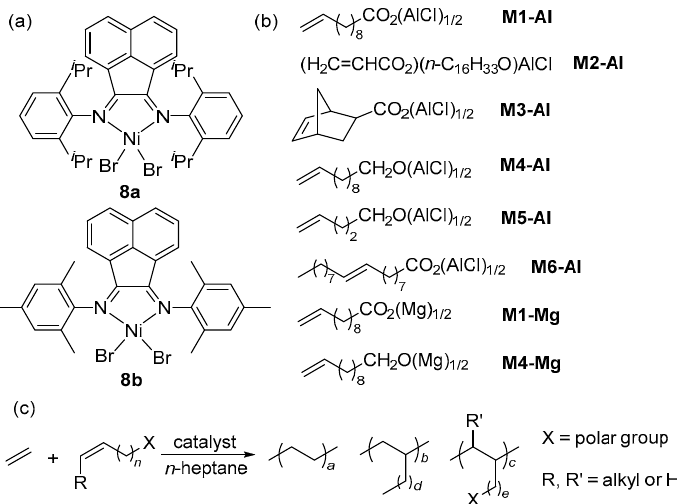
Figure 6. ( a ) Nickel catalysts 8a , b for olefin copolymerization; ( b ) different metal–salt-based polar monomers; ( c ) ethylene copolymerization with polar monomers.